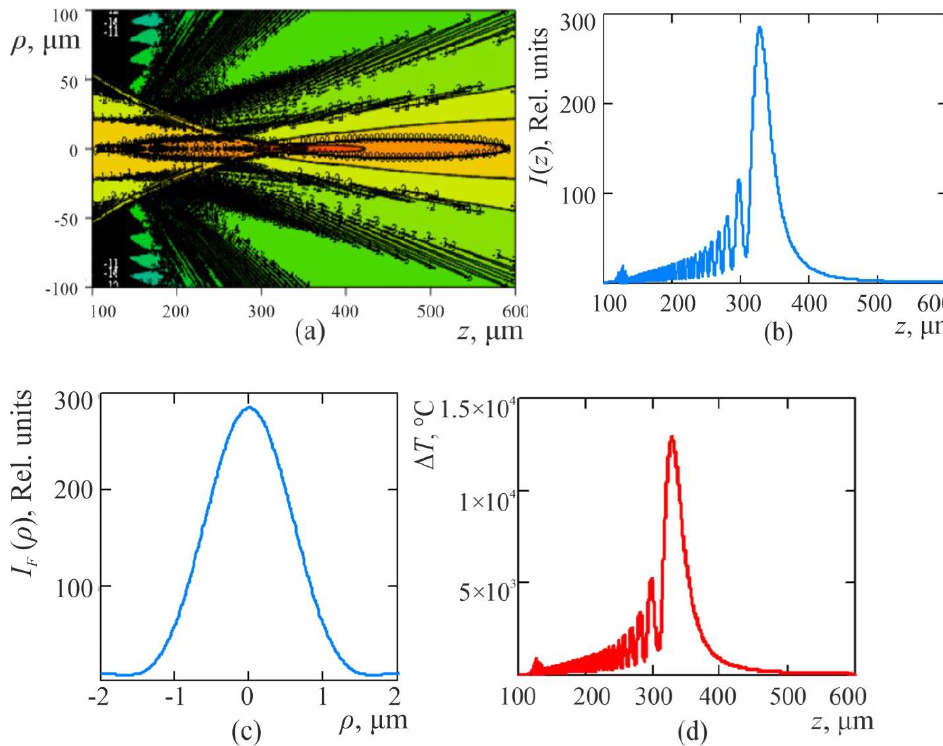
Figure 2. Laser beam structure [9,10] in a solution of ink in water (along the beam and in focus) focused by a single sphere 200 µ m in diameter. α = 9.5 × 10 − 3 µ m − 1 , λ = 0.532 µ m, R = 100 µ m, τ = 0.015 µ s. ( a ) Spatial intensity distribution, ( b ) distribution along the beam, ( c ) radial distribution in the geometric focus, ( d ) axial temperature distribution (neglecting sound travel time τ 1 = d / c ). The structure of the ultrasonic field generated by a single beam with diameter α can be described by Formula (4).